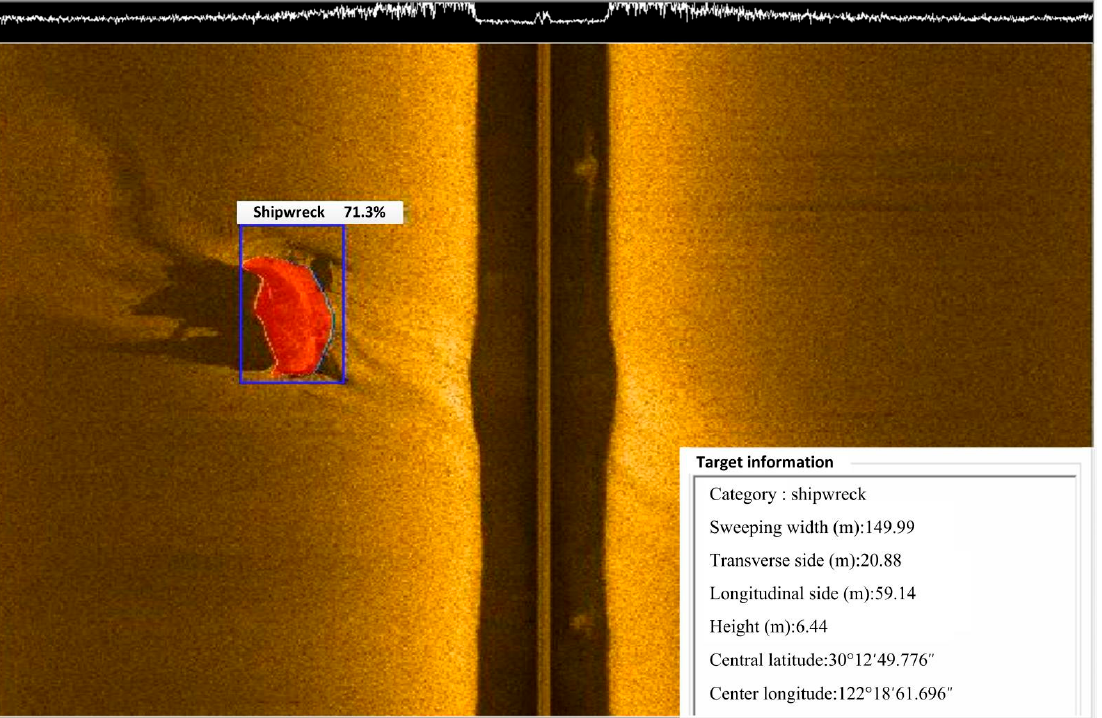
Figure 15. Task track in the Zhoushan Sea area.